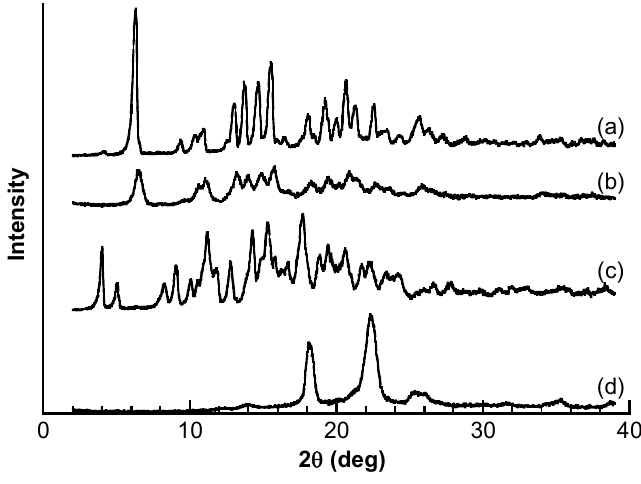
Figure 2. XRD patterns: ( a ) PEG/ γ -CyD PPRX; ( b ) PBA–PEG/ γ -CyD PPRX; ( c ) γ